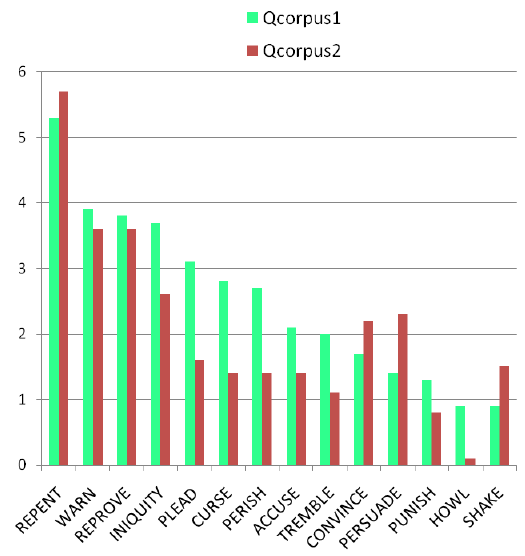
Figure 3. Comparison by relative percentage terms between high-frequency exhortatory language items in Qcorpus1 and Qcorpus2.